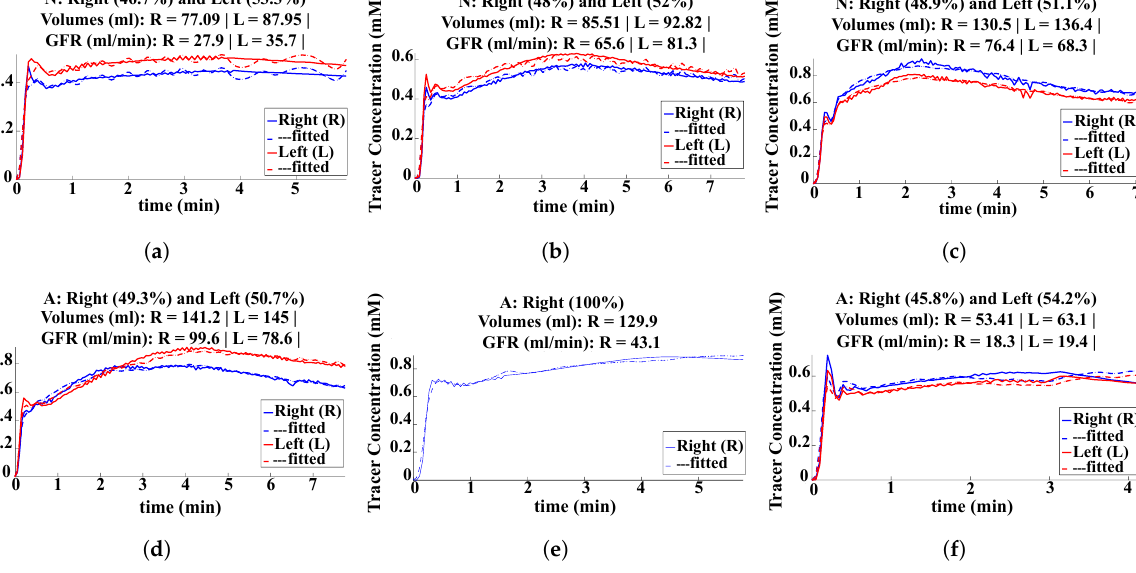
Figure 8. Graphs ( a – f ) represent clinically “normal” and “abnormal” cases (scans or 4D volumes), respectively.The tracer concentration is shown over time for both the right (blue) and left (red) kidneys; the corresponding kidney percentage, volume (mL) and GFR (mL/min) were computed to discern and evaluate separate kidney